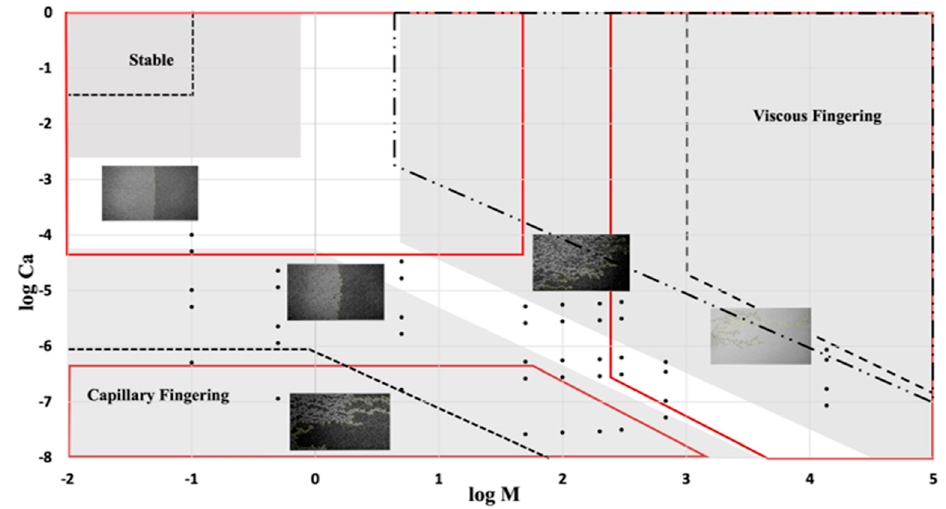
Figure 5. Drainage flow phase diagram. The solid (red) boxes are based on our results; the shaded areas are based on work by Zhang et al. [5]; the dot-dash line is based on the study by Liu et al. [38]; and regimes delineated with dashed lines are based on work by Lenormand et al. [9].